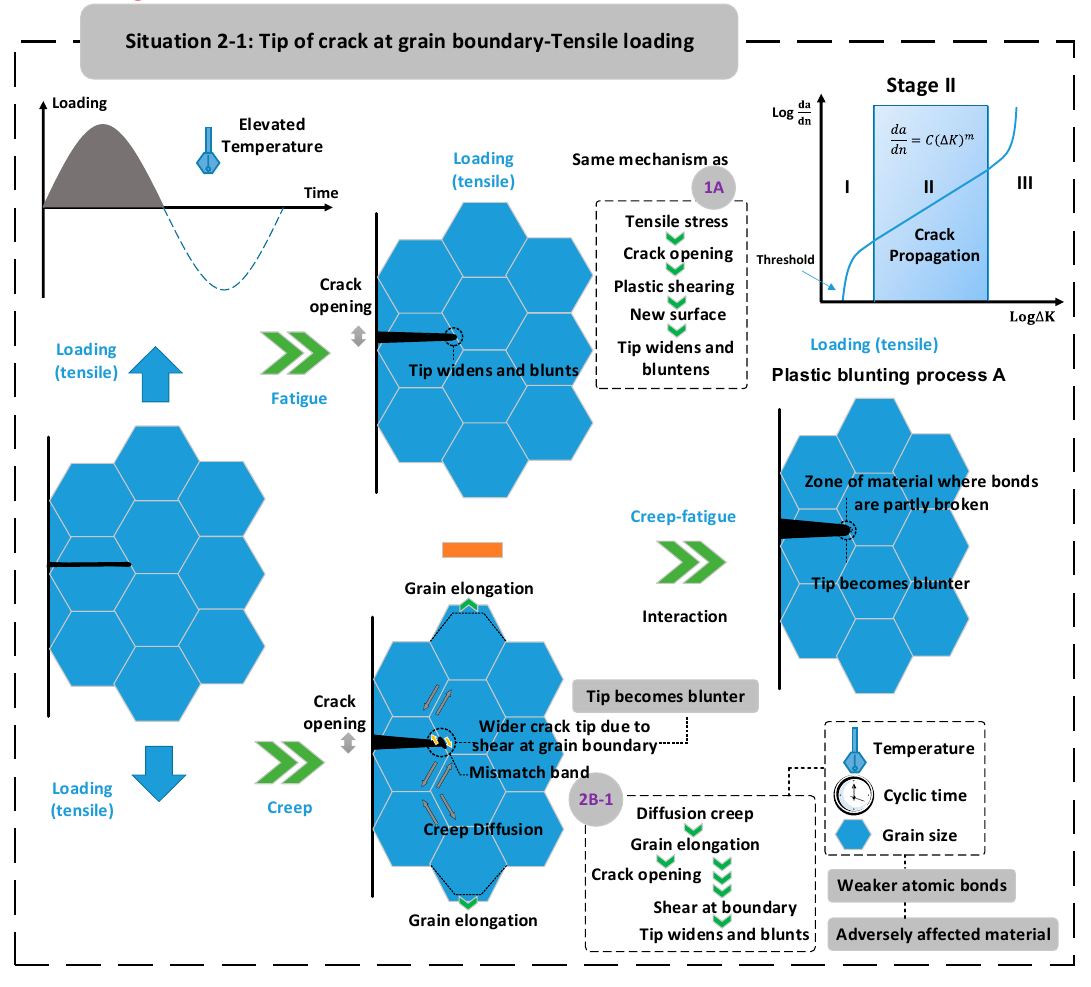
Figure 11. Crack tip at grain boundary—Tensile loading.